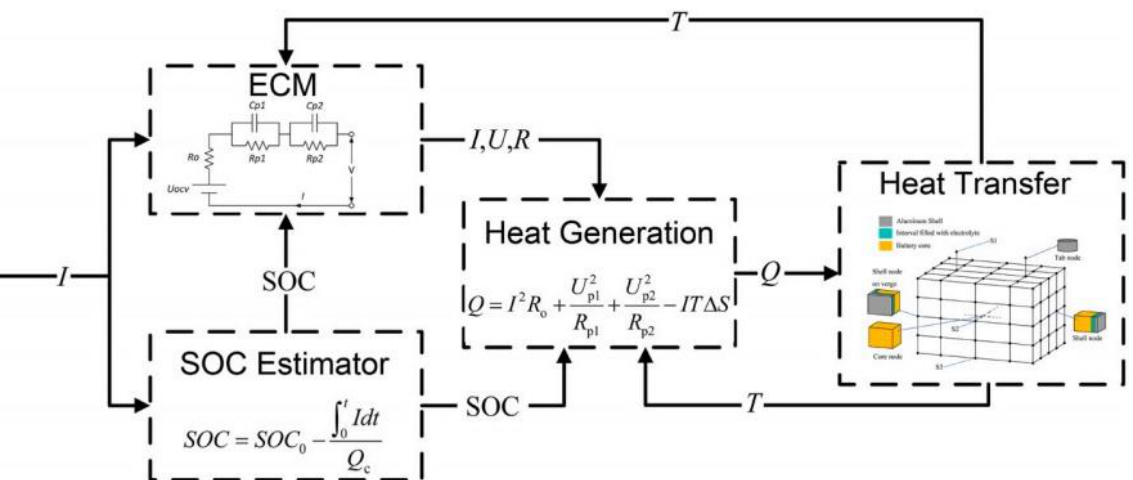
Figure 12. Schematic illustration of the multi-node and coupled electro-thermal concept. Reprinted with permission from [67]. Copyright 2020 Elsevier.